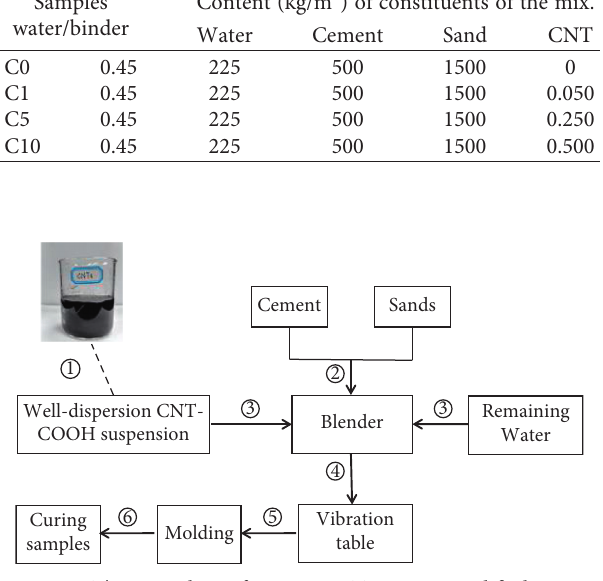
Table 4: Mix proportion of CNT-COOH-dosed mortar samples. Samples Content (kg/m 3 ) of constituents of the mix. water/binder